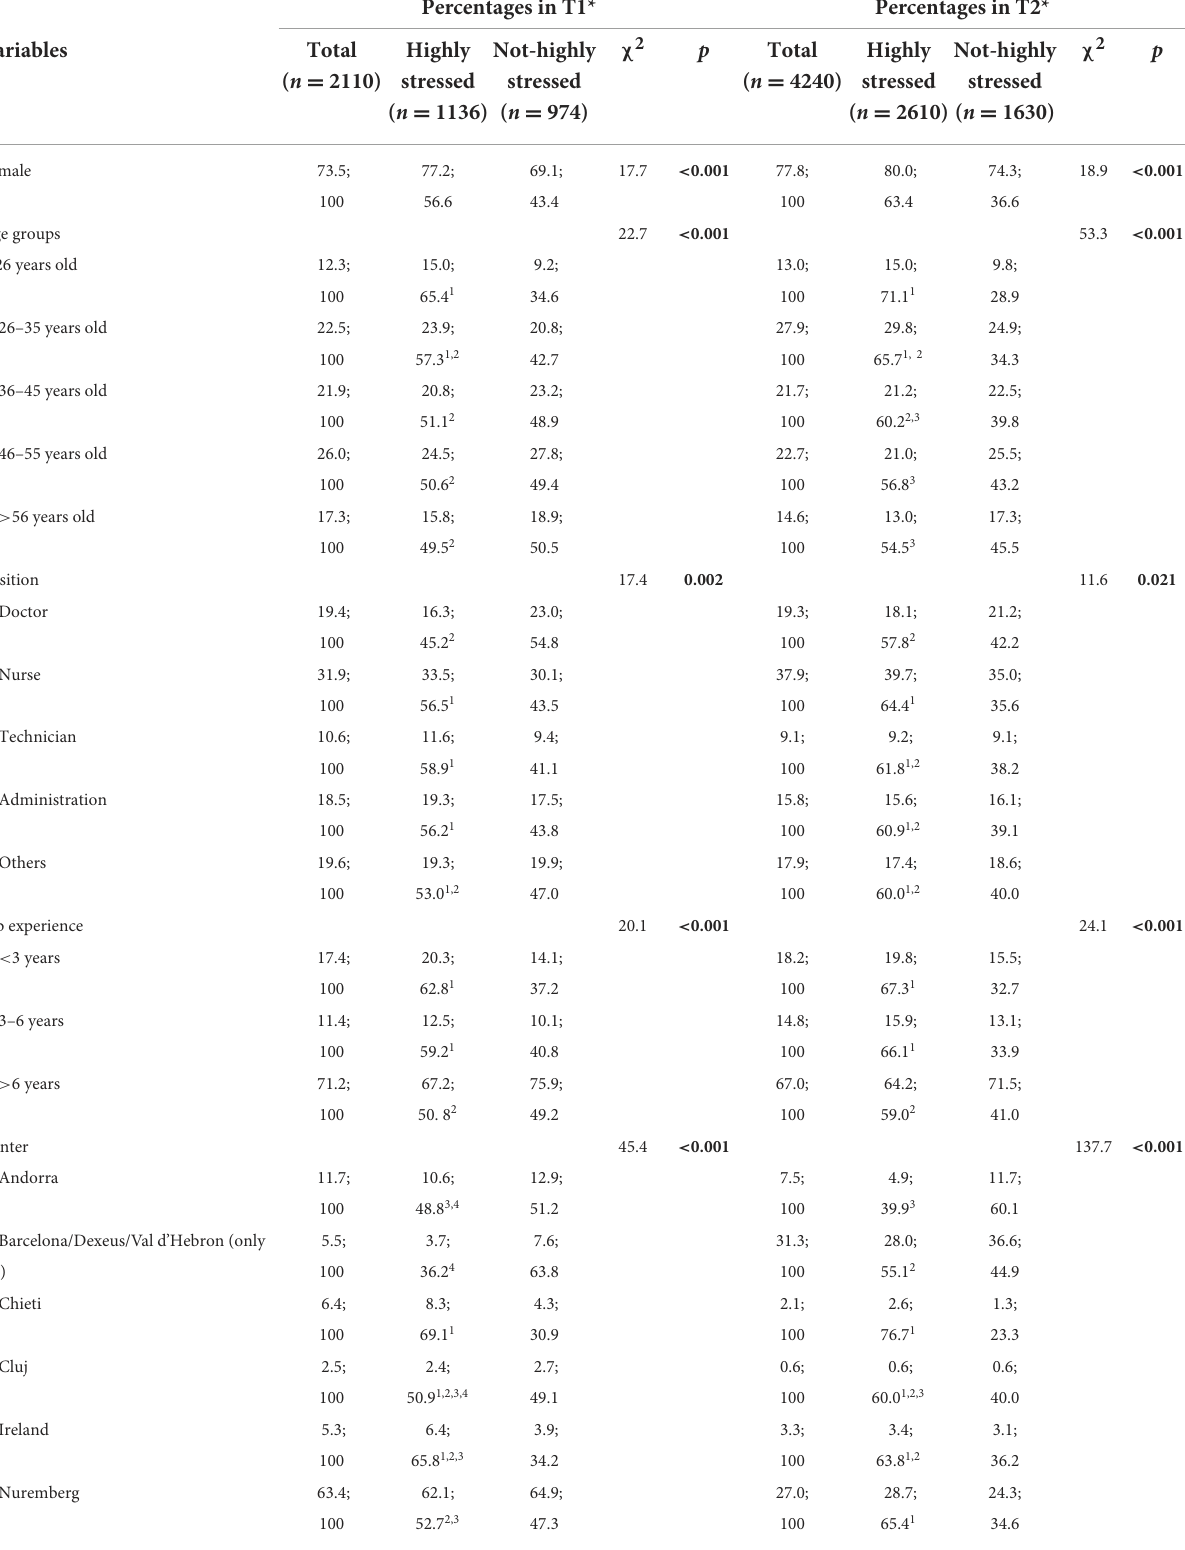
TABLE 1 Demographic and occupational characteristics of HCWs at T1 ( n = 2,110) and T2 ( n =